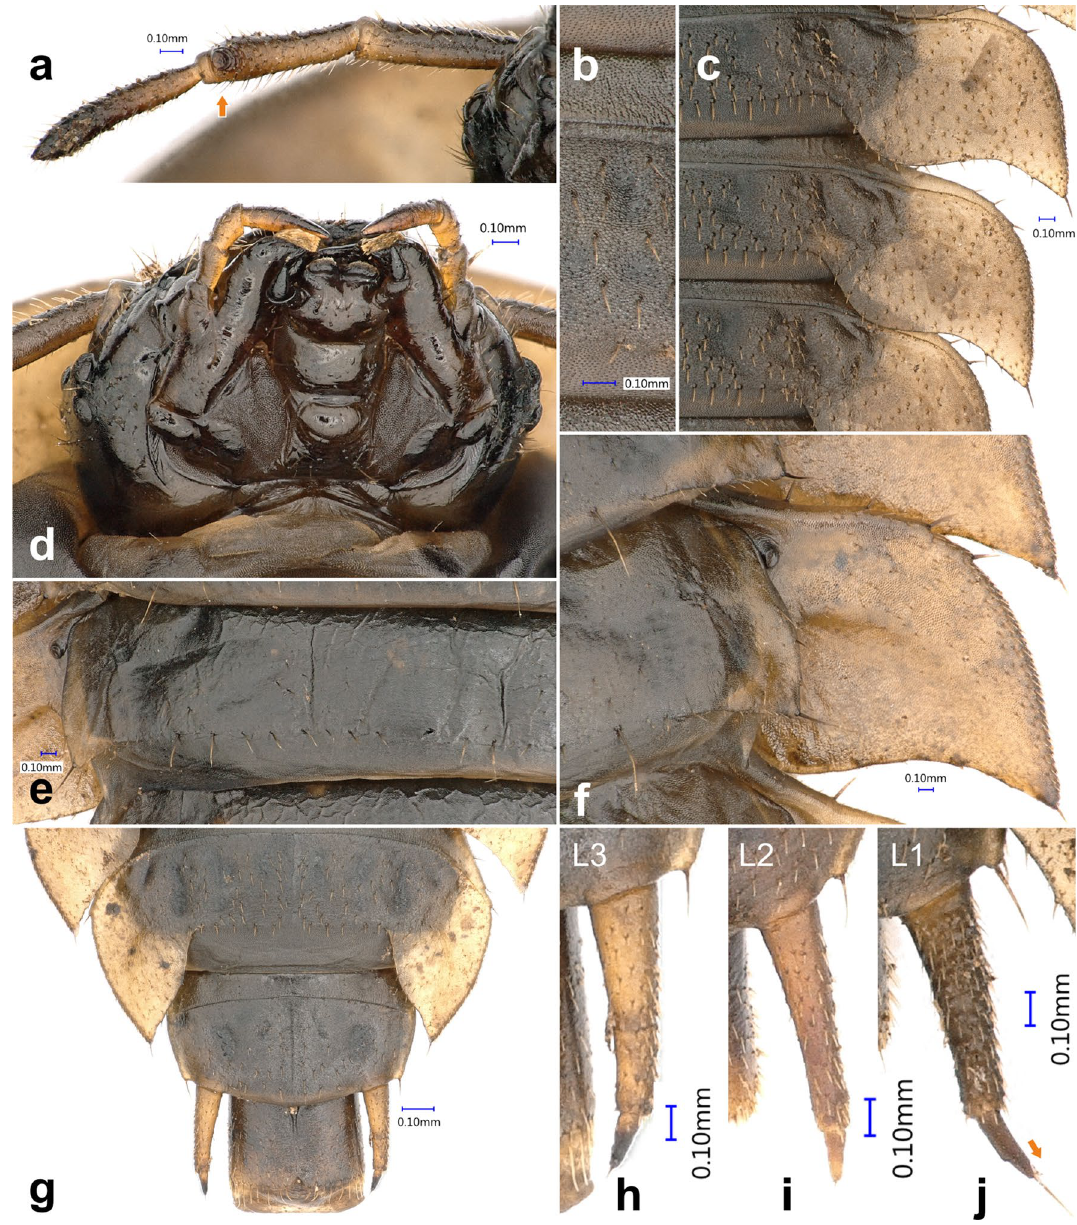
Figure 4. Heterotemna tenuicornis (Brullé, 1836), details of external morphology of larva: ( a ) antenna, dorsal view; ( b ) abdominal tergite, dorsal view; ( c ) abdominal tergites and paratergites, dorsal view; ( d ) head, ventral view; ( e ) abdominal ventrite, ventral view; ( f ) abdominal paratergite, ventral view; ( g ) abdominal tergites 8–10, dorsal view; ( h – j ) urogomphus, dorsal view, ( a , b , d – h ) third instar, ( i ) second instar, ( c , j ) first